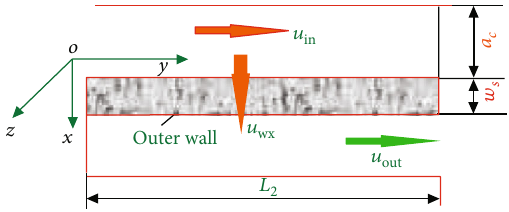
Figure 2: Model of inlet and outlet channel of the